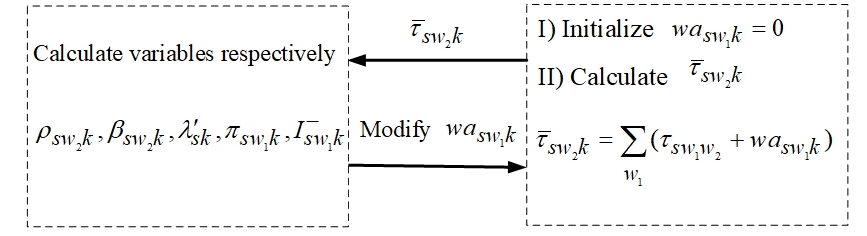
Fig. 2. A heuristic approach for the inventory